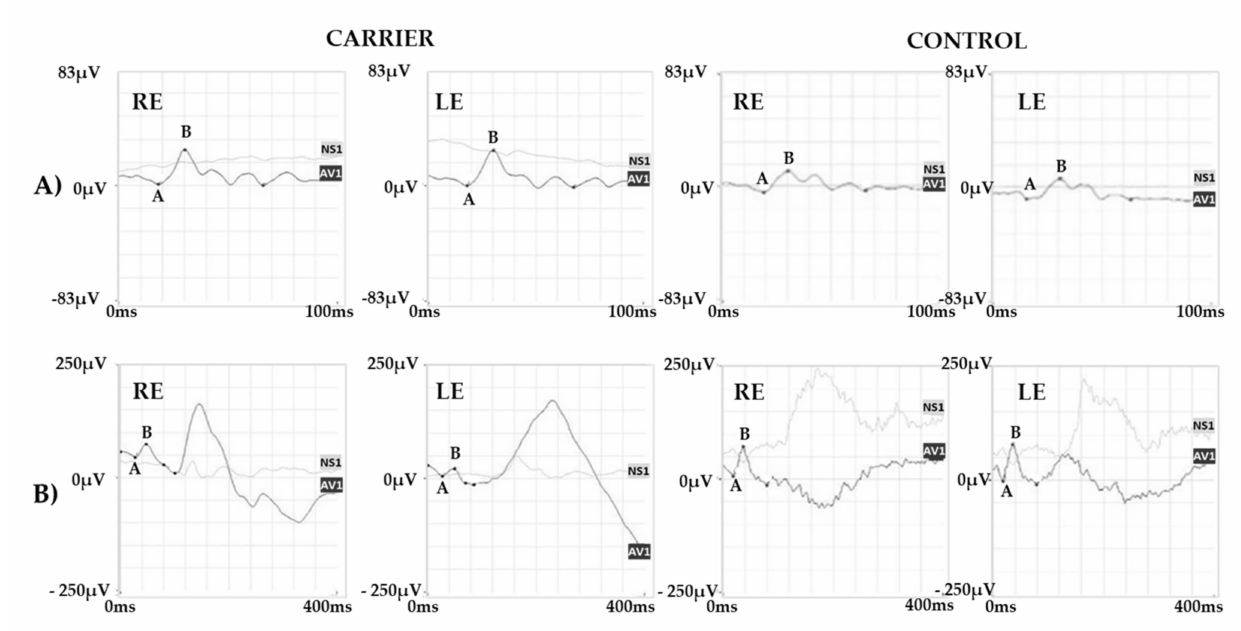
Figure 6. Specialized ERG responses. ( A ) S cone and ( B ) M-L cone-mediated ERG recordings from the carrier and a control subject. Note that S cone ERG shows a normal amplitude response while the M-L cone response is delayed and reduced as compared with the normal control. Legend: RE, right eye; LE, left eye; AV1, average response; NS1, noise signal; A, a-wave; B,